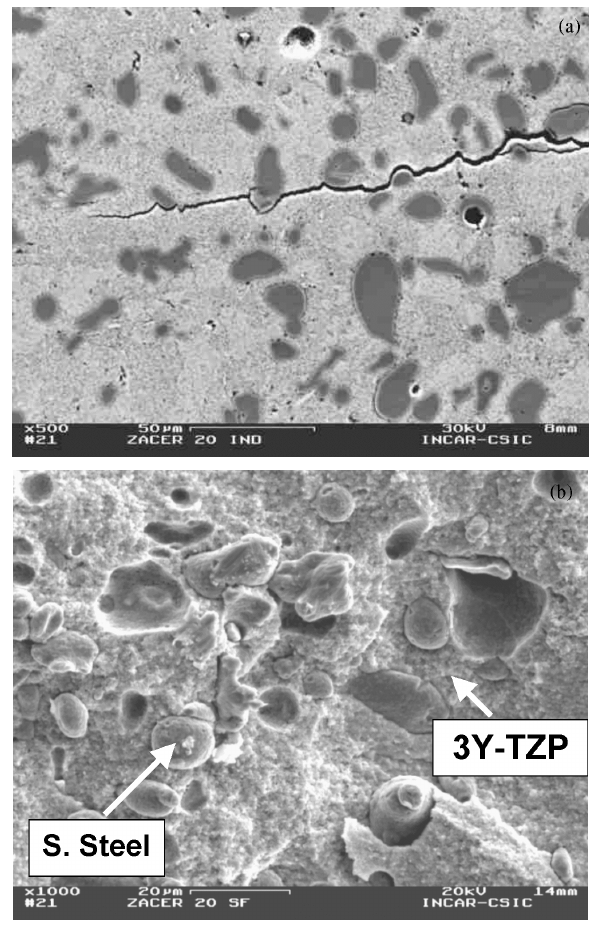
Figure 5. A) SEM micrograph illustrating the form of a crack initiated through a Vickers indentation in sample with 20 vol.% metal. Lighter phase is zirconia and the darker phase is metal. B) SEM micrograph of fracture surface of the same ZrO 2 /stainless steel